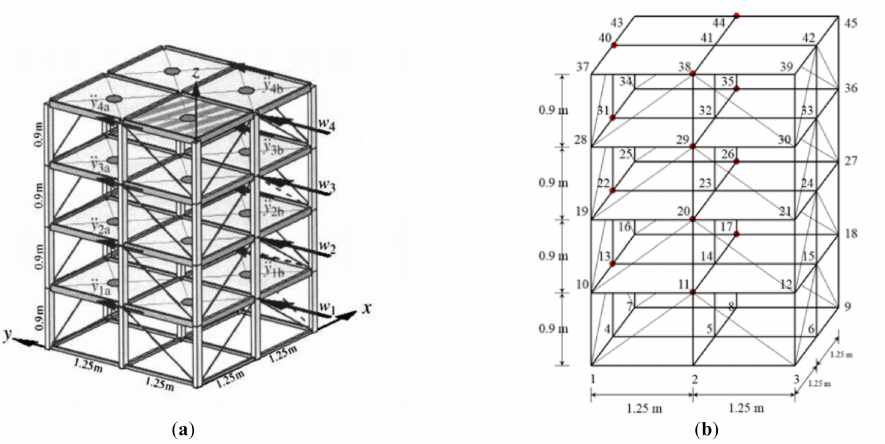
Figure 4. ASCE benchmark structure used for health monitoring: ( a ) The analytical model [24] ( b ) Distribution of node